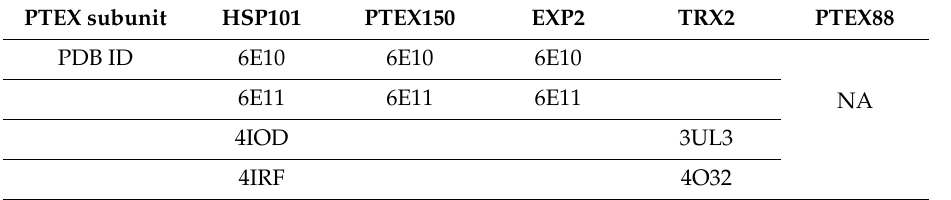
Figure 2. Malaria effector proteins are secreted by PTEX. ( A ) The Plasmodium translocon of exported proteins is a vacuolar membrane protein complex that translocates effector malarial proteins across the parasitophorous vacuole membrane (PVM) surrounding the Plasmodium parasite following invasion of the human red blood cell. ( B ) The core of PTEX is composed of HSP101/ClpB2, PTEX150, and EXP2, is complemented by accessory proteins TRX2 and PTEX88. Simplified drawing of PTEX emphasizing the core subunit stoichiometry and the six-to-seven symmetry mismatch, with three views of the core PTEX structure determined by cryo-EM [26] . Table 1. Protein Data Bank identifiers for PTEX protein structures.